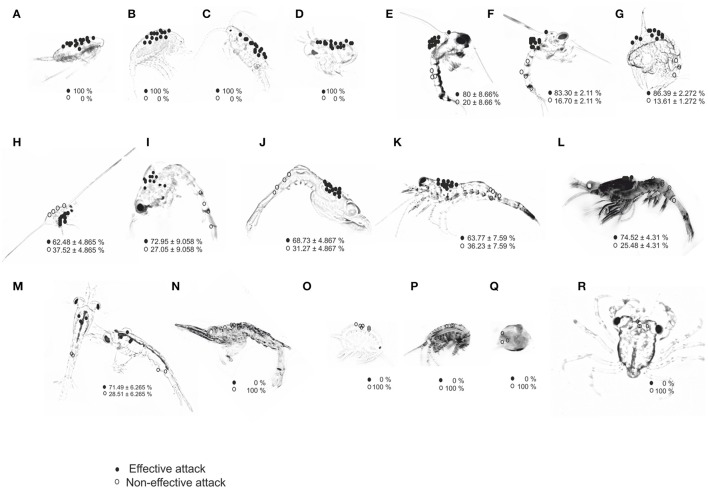
Location of attack sites (circles) by paralarvae of O. vulgaris on different prey types: (A)
Acartia clausii; (B)
Temora longicornis; (C)
Centropages sp.; (D)
Podon intermedius; (E)
Carcinus maenas; (F)
Cancer pagurus; (G)
Maja brachydactyla; (H)
Pisidia longicornis; (I) Paguridae; (J) Processidae; (K) Hippolytidae; (L) Palaemonidae; (M)
Nyctiphanes couchii; (N) Crangonidae; (O) Gammarid amphipod; (P) Hyperiid amphipod; (Q) Gastropods; (R) Brachyura megalopae. Prey images are not to scale to identify all preys in the same panel; actual prey size is given in Table 1. Percentage of EA (effective attacks, filled circles) and IA (ineffective attacks, open circles) are given per prey type.